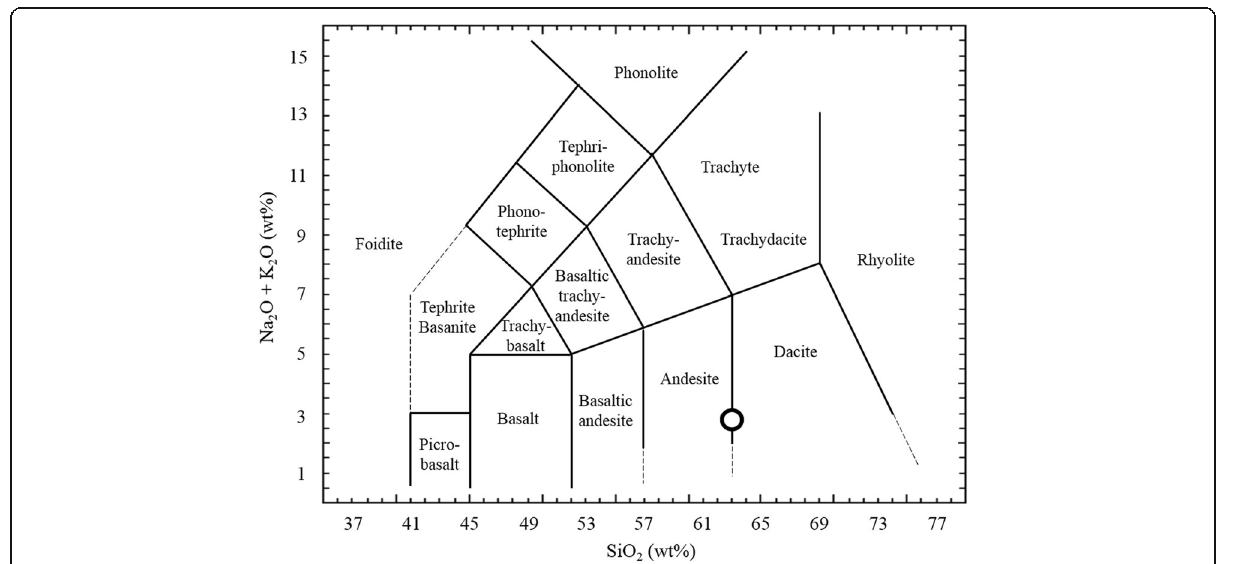
Fig. 8 Total alkali-silica (TAS) diagram (Le Bas et al. 1992). White circle represents the silicic clast (this